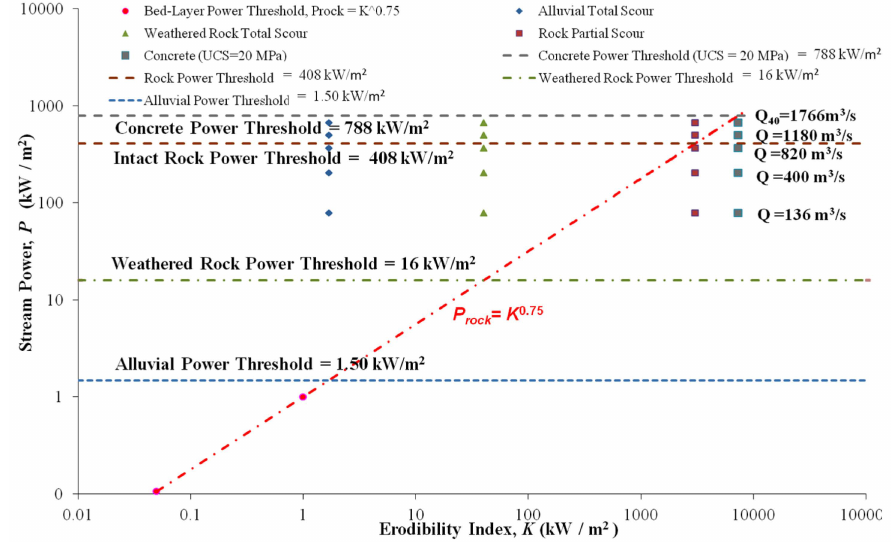
Figure 8. Stream power of the jet for different flows as a function of the erodibility. Alluvial, weathered rock and intact rock indexes ( Y s = 18 m, Y 0 = 6 m) for the half-height